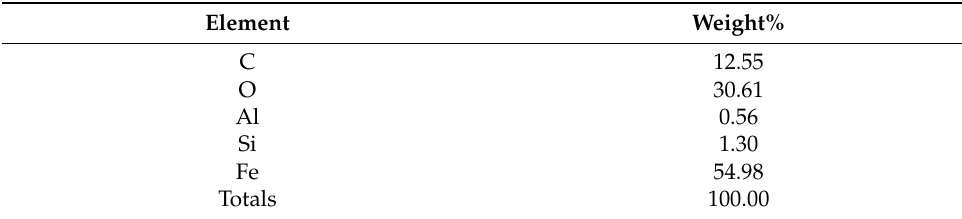
Table 4. Elemental composition of synthesized iron oxide particles as found by